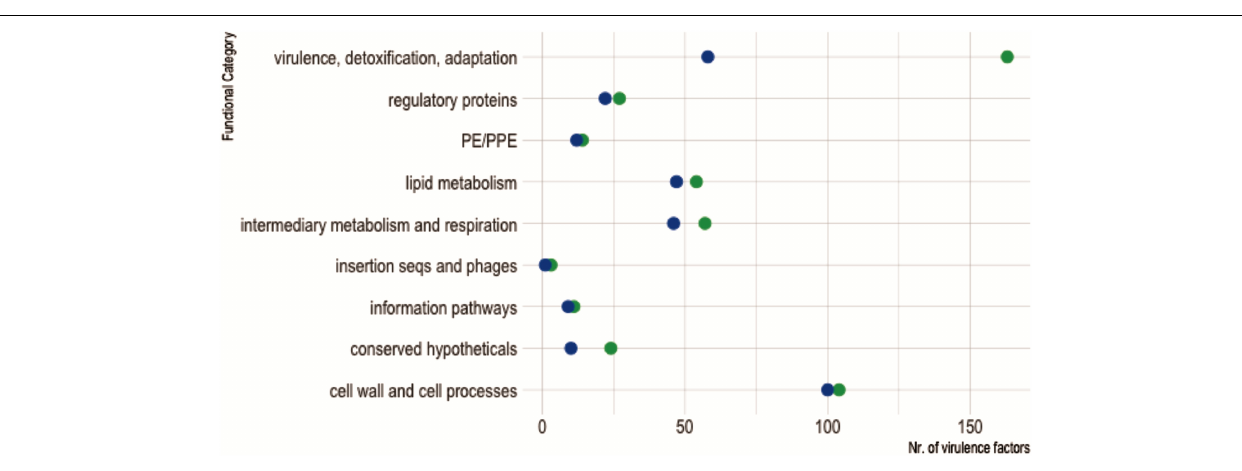
FIGURE 8 | Virulence factors shared between Mycobacterium kansasii ATCC 12478 and Mycobacterium tuberculosis H37Rv, according to their functional categories. The diagram shows the distribution of virulence factors encoded in each mycobacterial genome according to their assigned functional category, as defined in Mycobrowser classification (https://mycobrowser.epfl.ch/). Green dots represent M. tuberculosis H37Rv virulence factors, while blue dots account for homologous counterparts in M. kansasii ATCC